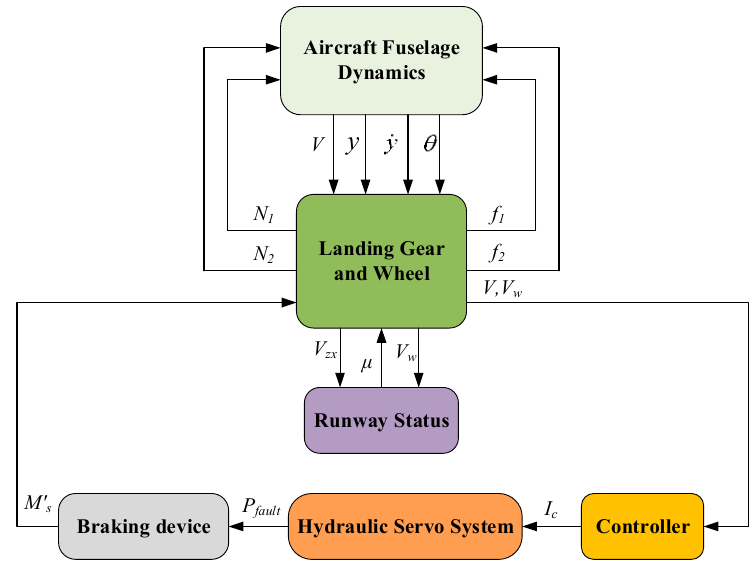
Figure 3. Overall components of aircraft anti-skid braking system .